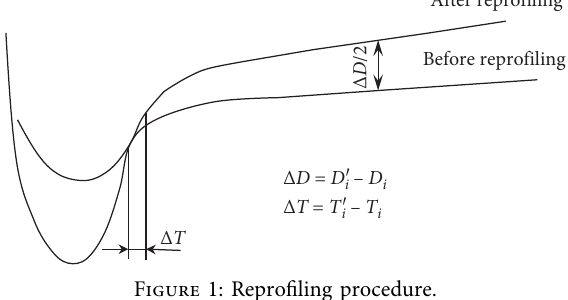
Figure 1: Reprofiling